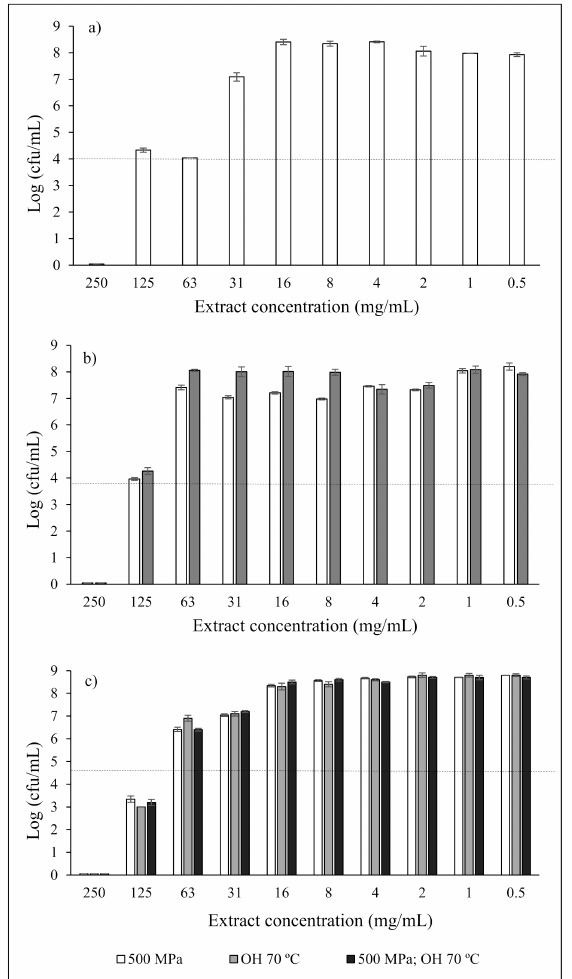
Figure 2. Microbiological loads of ( a ) B. cereus , ( b ) S. aureus , and ( c ) S. enteritidis for the different extract concentrations. The horizontal line in the graphs represents the initial load of microorganism added to the